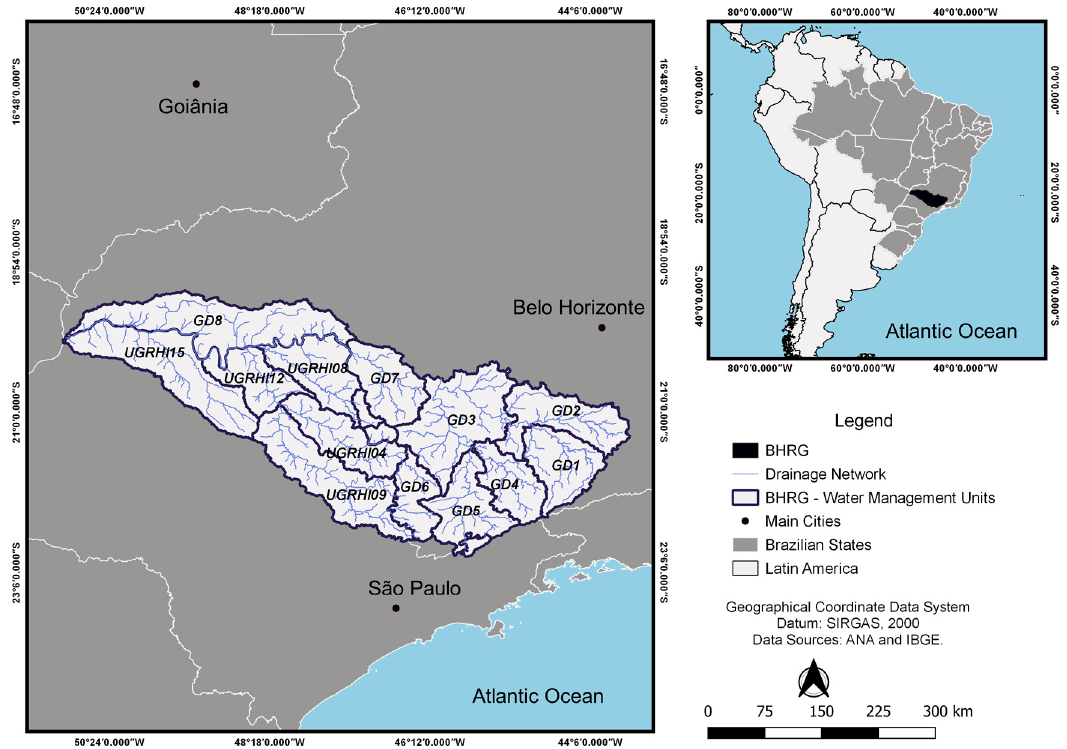
Figure 1. River Grande Basin (BHRG) and its respective Water Management Units (UGHs), located in Minas Gerais State (GDs) and São Paulo State (UGRHIs).